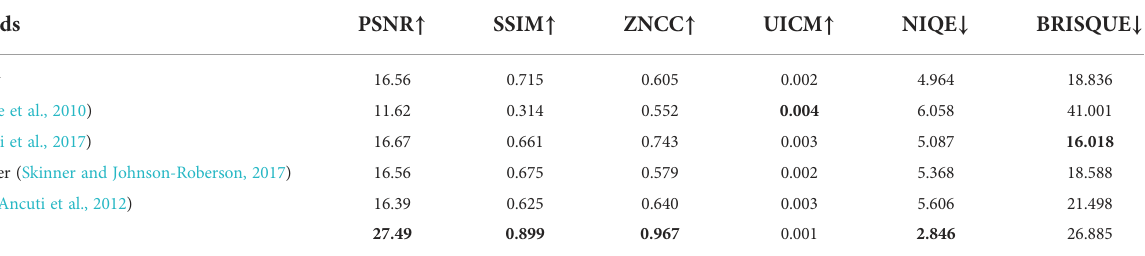
TABLE 3 Average evaluation metrics on the test set.